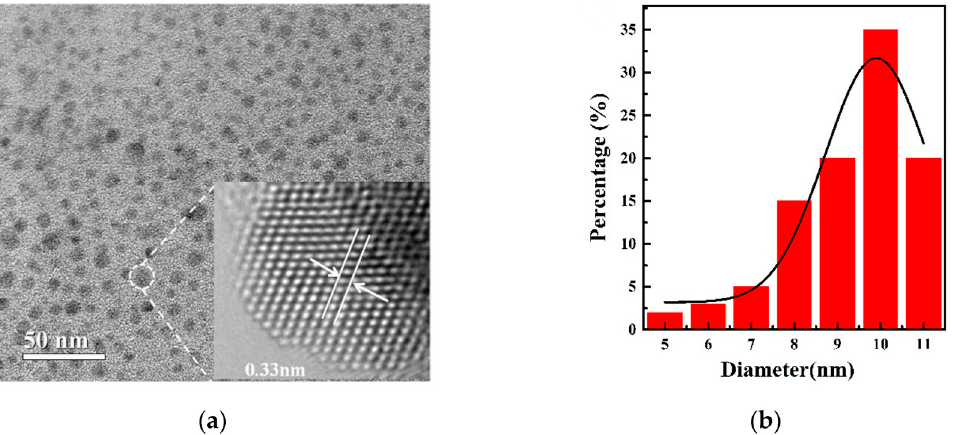
Figure 2. ( a ) TEM image of SnSe 2 QDs with a centrifugal speed of 6000 rpm. The inset shows the detailed crystal structure of a single QD; ( b ) the size distribution of the SnSe 2